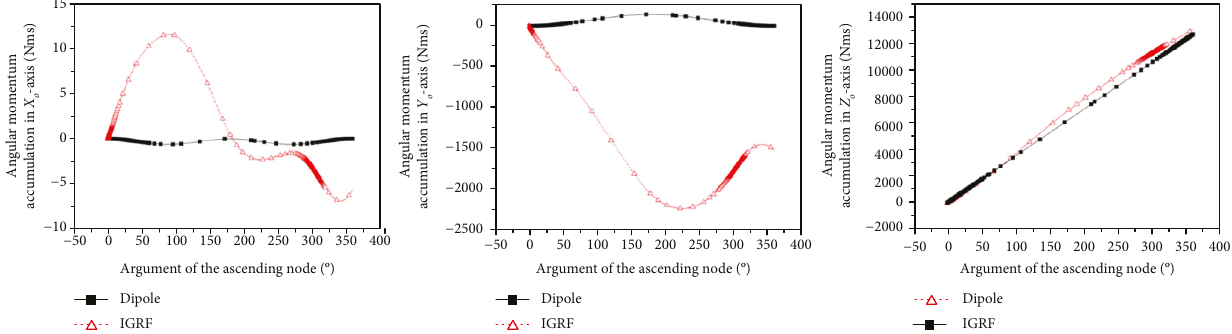
Figure 7: Angular momentum accumulation (orbital coordinates) in the circular orbit (950km) by the dipole and IGRF11 model under equation (11) (example